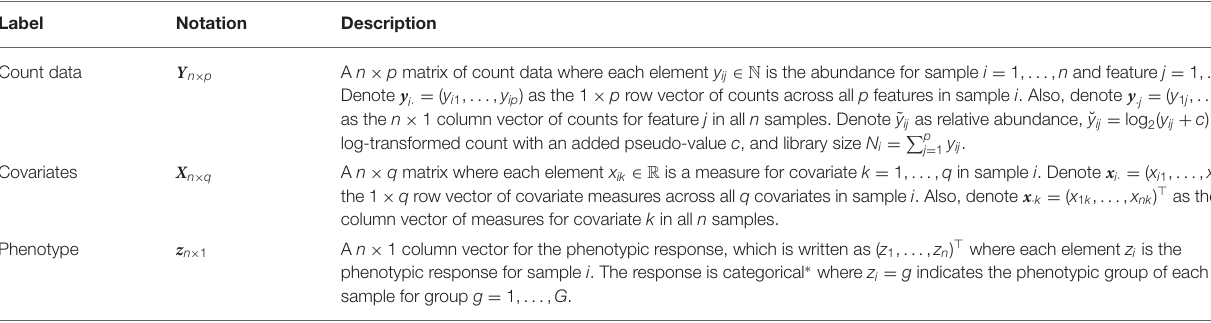
TABLE 1 | The notations and descriptions of typical microbiome data.